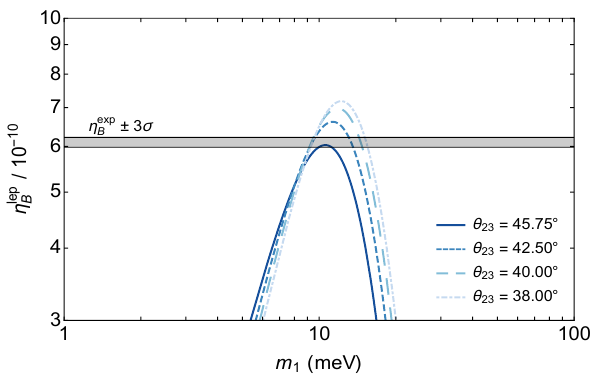
Figure 2 . Plot of the (cid:12)nal asymmetry from leptogenesis as a function of the neutrino mass m 1 . The di(cid:11)erent lines correspond to the four indicated values of (cid:18) 23 each for one of the four regions in (cid:12)gure 1. The other neutrino parameters are (cid:12)xed to: (cid:14) ’ (cid:0) 75 (cid:14) , (cid:26) ’ 0 : 23 (cid:25) , (cid:27) ’ 0 : 84 (cid:25) , (cid:26) L ’ 0 : 06 (cid:25) , (cid:27) L ’ 1 : 1 (cid:25) , (cid:14) L ’ (cid:0) 0 : 47 (cid:25) , (cid:18) L ’ 0 : 08 (cid:14) , (cid:18) L ’ 2 : 2 (cid:14) and (cid:18) L ’ 12 : 1 (cid:14) 13 23 12